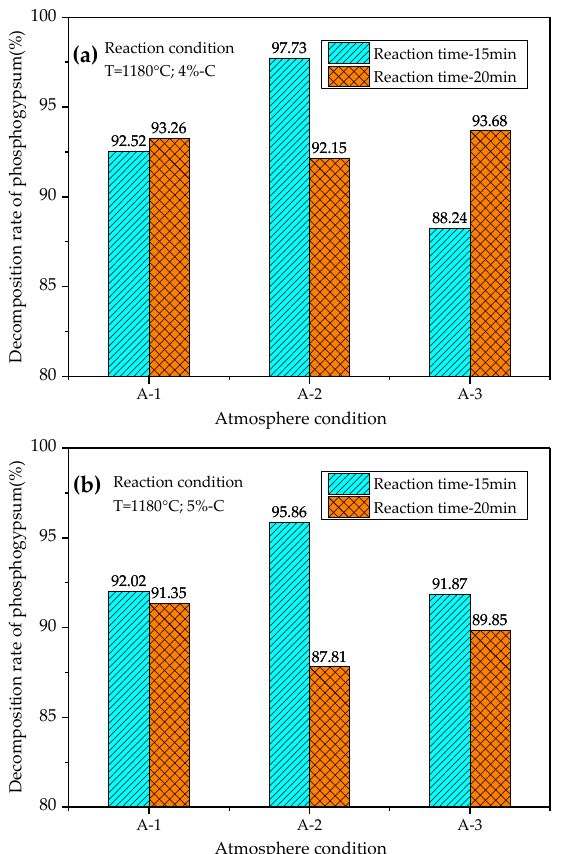
Figure 6. Decomposition rate ( φ ) of phosphogypsum under different atmosphere conditions: ( a ) the reaction temperature 1180 °C, time 15 min, carbon powder addition 4%; ( b ) the reaction temperature 1180 °C, time 20 min, carbon powder addition 5%.